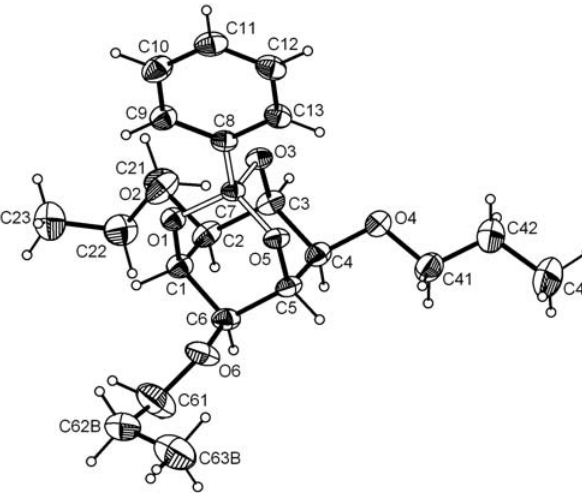
Table 1. Data collection and handling.